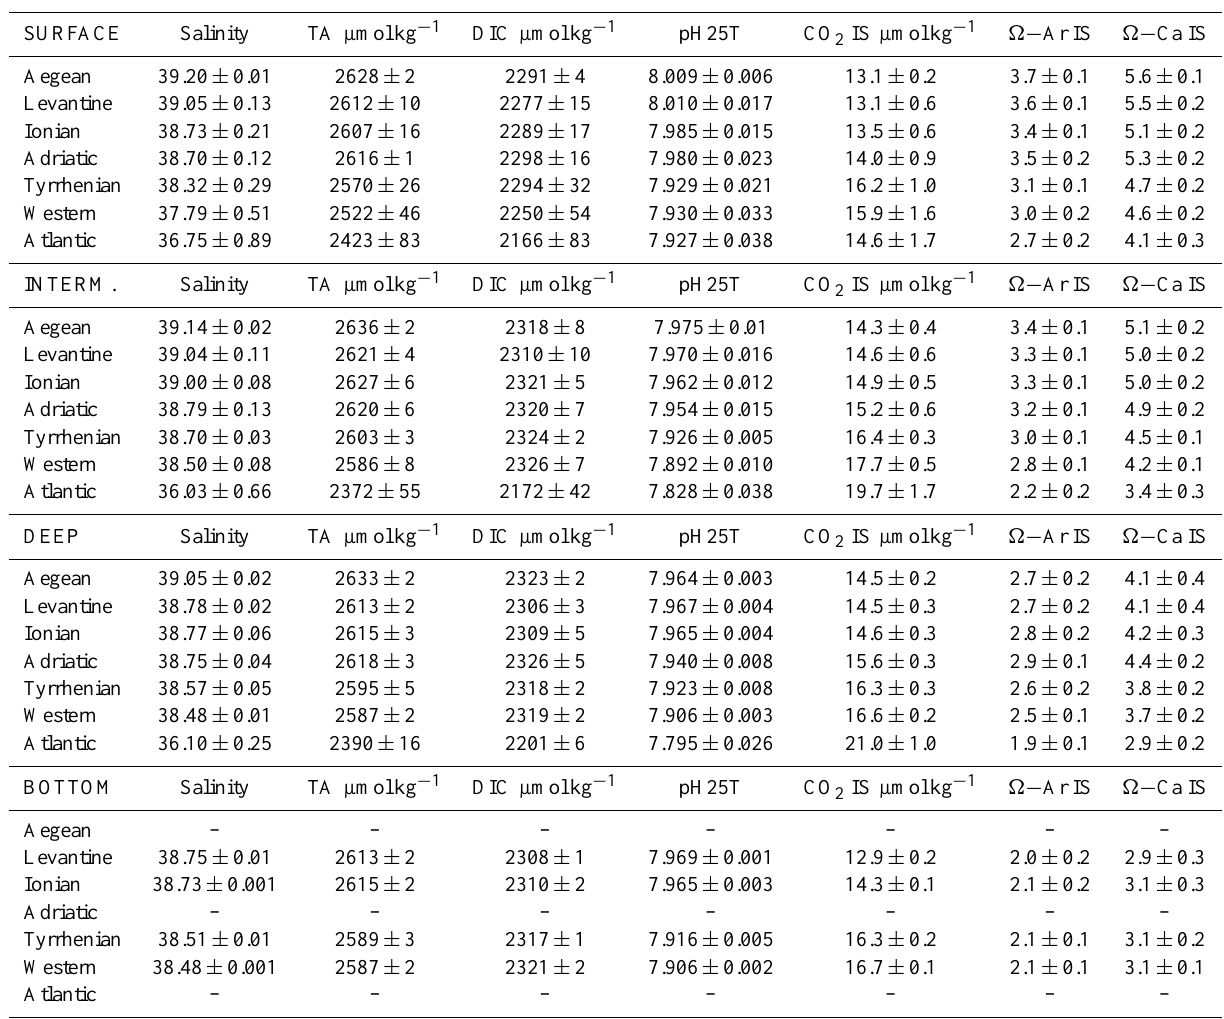
Table 2. Mean values and standard deviation for salinity and CO 2 species in the different MedSea sub-basins and west of the Strait of Gibraltar as sampled during the M84/3 cruise. Several vertical intervals are considered: surface (0–150dbars in the East and 0–200dbars in the West MedSea), intermediate (East: 150–500 and West: 200–500dbars), deep (East: 500–2500 and West: 600–2000dbars) and bottom (East: > 2500 and West: > 2000dbars). IS stands for in situ values. Ar stands for aragonite and Ca for